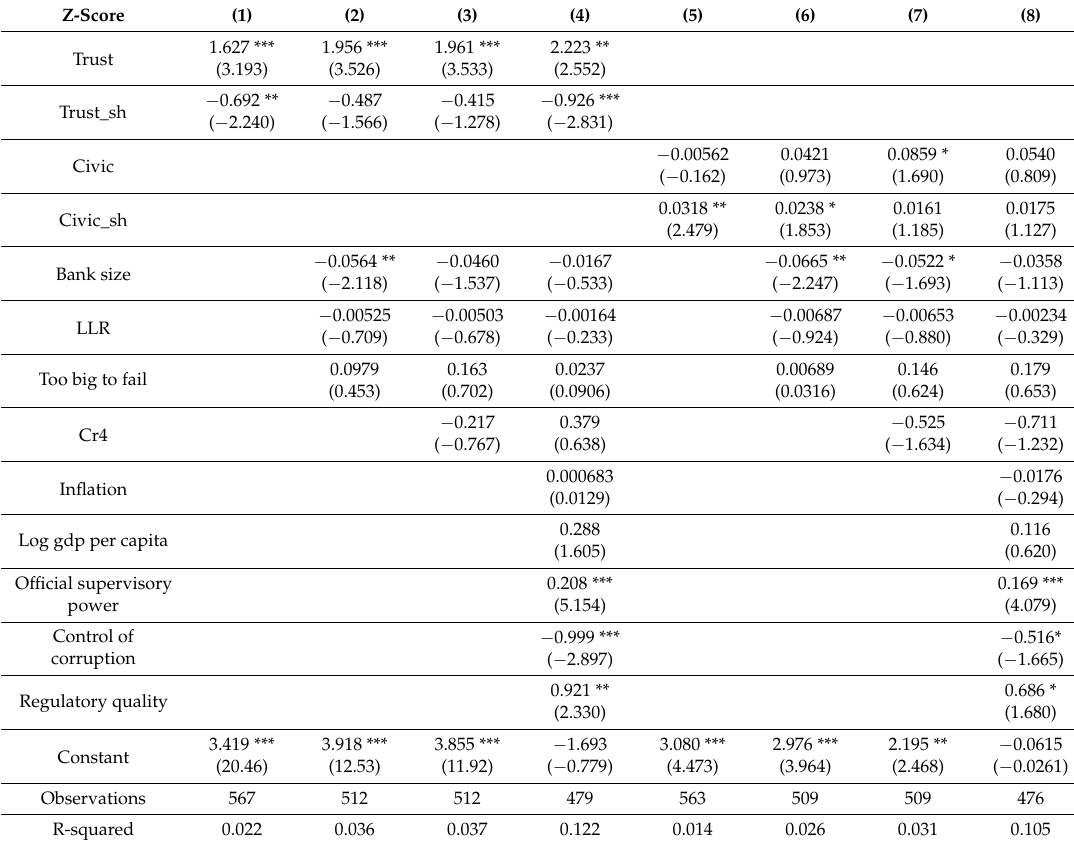
Table 9. Social capital of the shareholder’s